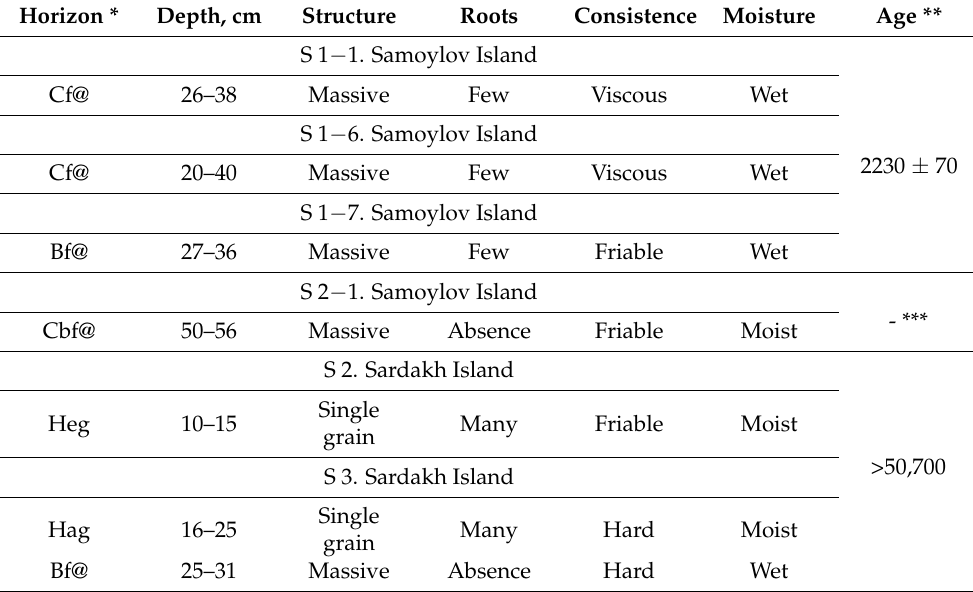
Table 2. Description of the Soil Monoliths Used for Thin